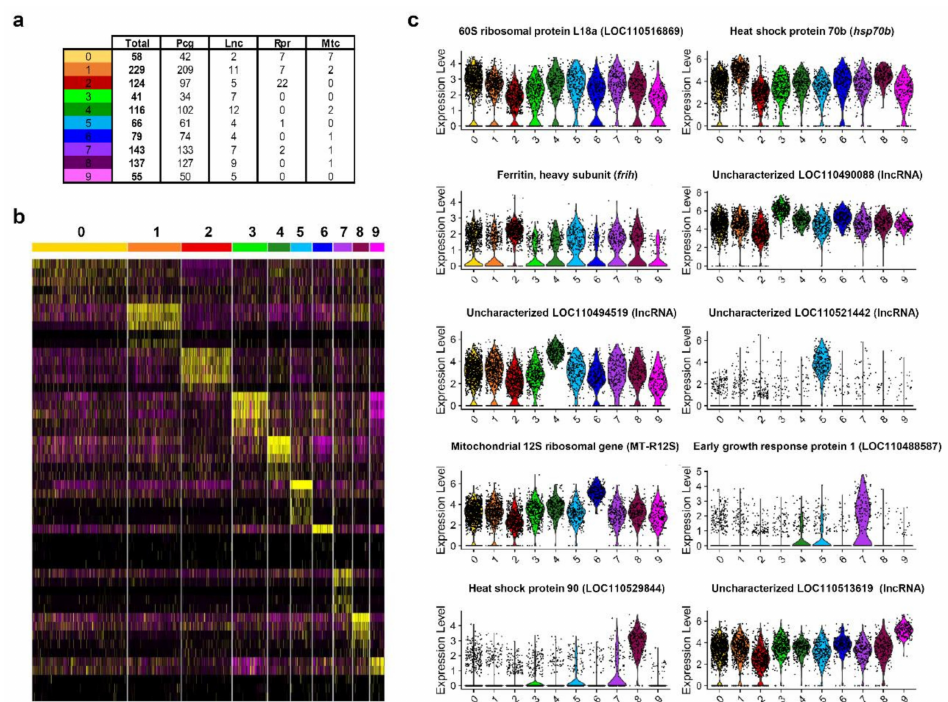
Figure 2. Identification of transcripts specific for each rainbow trout B cell subset. ( a ) Table including the number of transcripts identified for each cell cluster showing significant differences in expression levels (adjusted to p < 0.001) differentiating among protein coding genes (Pcg), long non-coding RNAs (Lnc), genes coding for ribosomal proteins (Rpr) and mitochondrial genes (Mtc). ( b ) Heatmap showing expression levels from the top five most significant subset-specific transcripts for each B cell subset ( c ) Violin plots showing normalized expression levels in all B cell subsets for the most significant marker transcript in each B cell